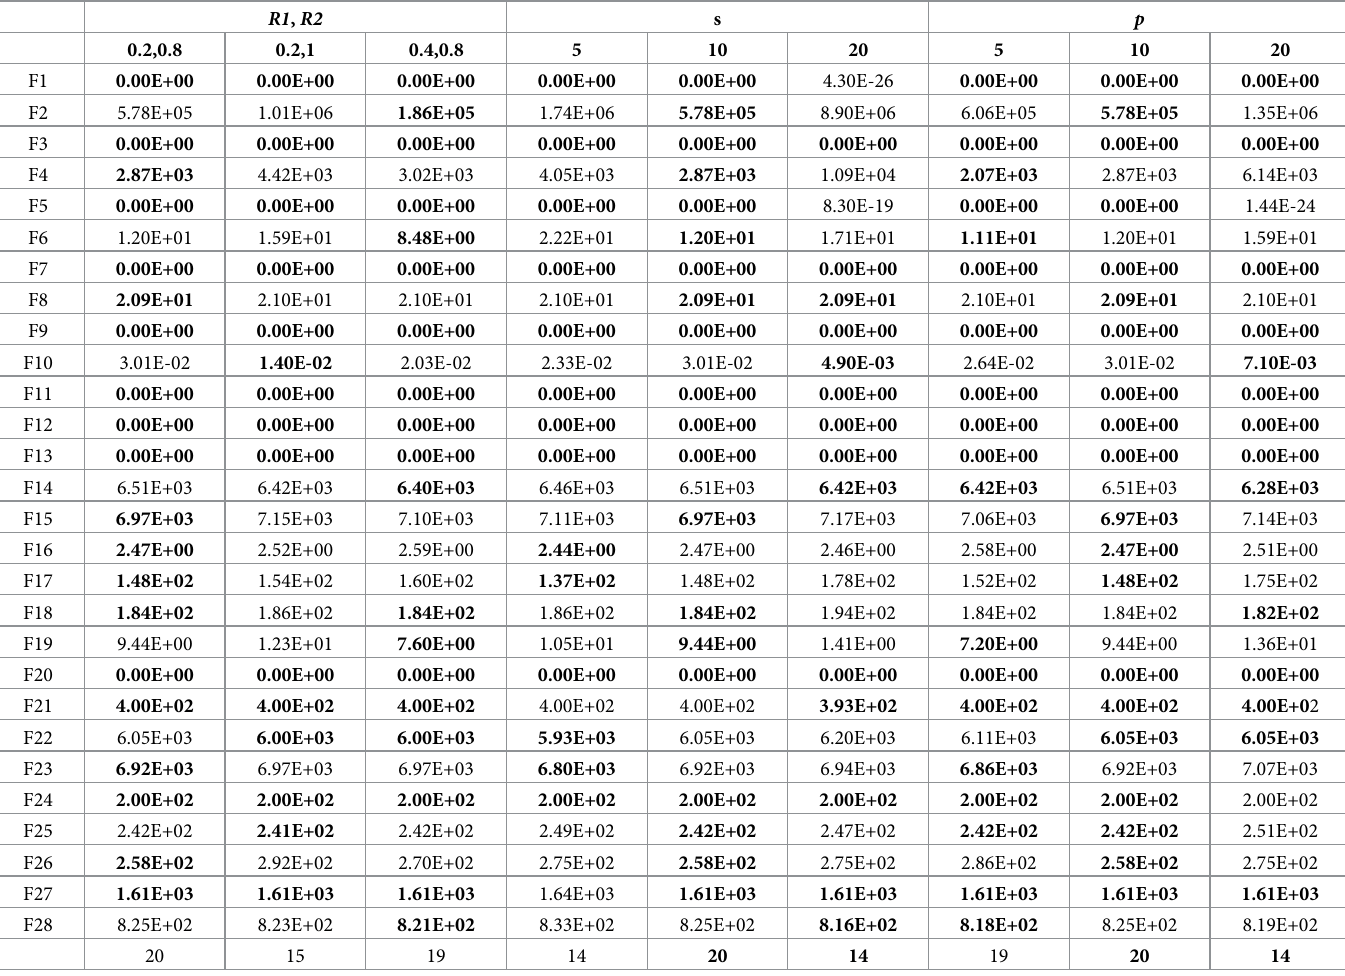
Table 2. Sensitivity analysis with R1 , R2 , s , p